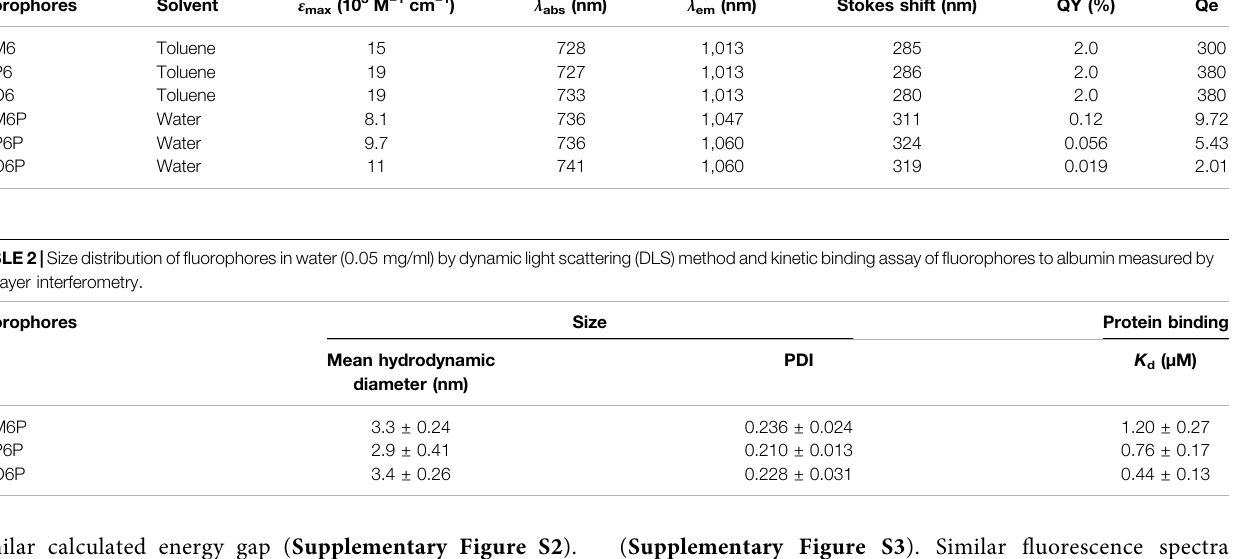
TABLE 1 | Optical data of the fl uorophores. QE (brightness) (cid:2) QY × ε . Fluorophores